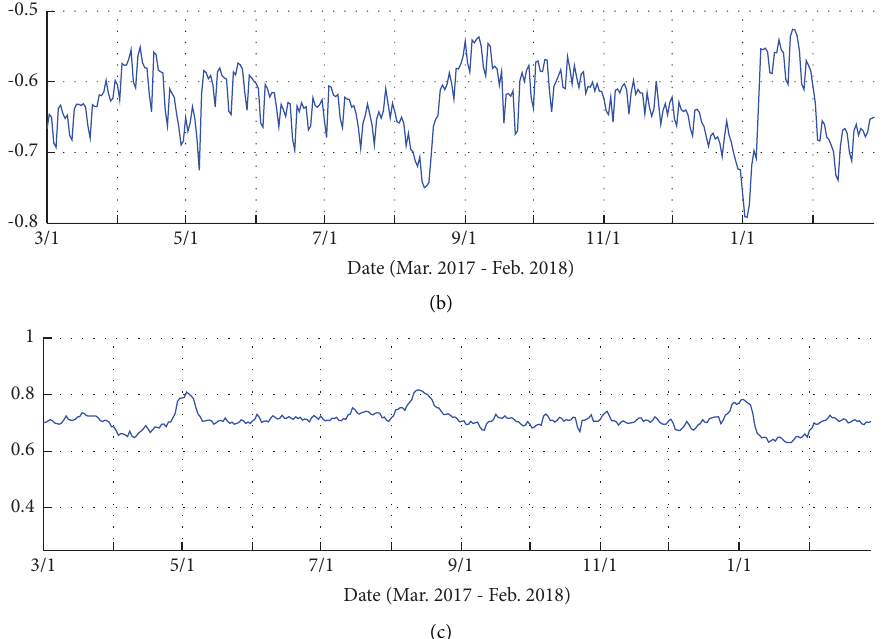
Figure 13: Regression analysis results for 365 days of travel cost values. (a) Estimated coefcients of distance (100km). (b) Estimated coefcients of minimum travel time (hour). (c) R -squared